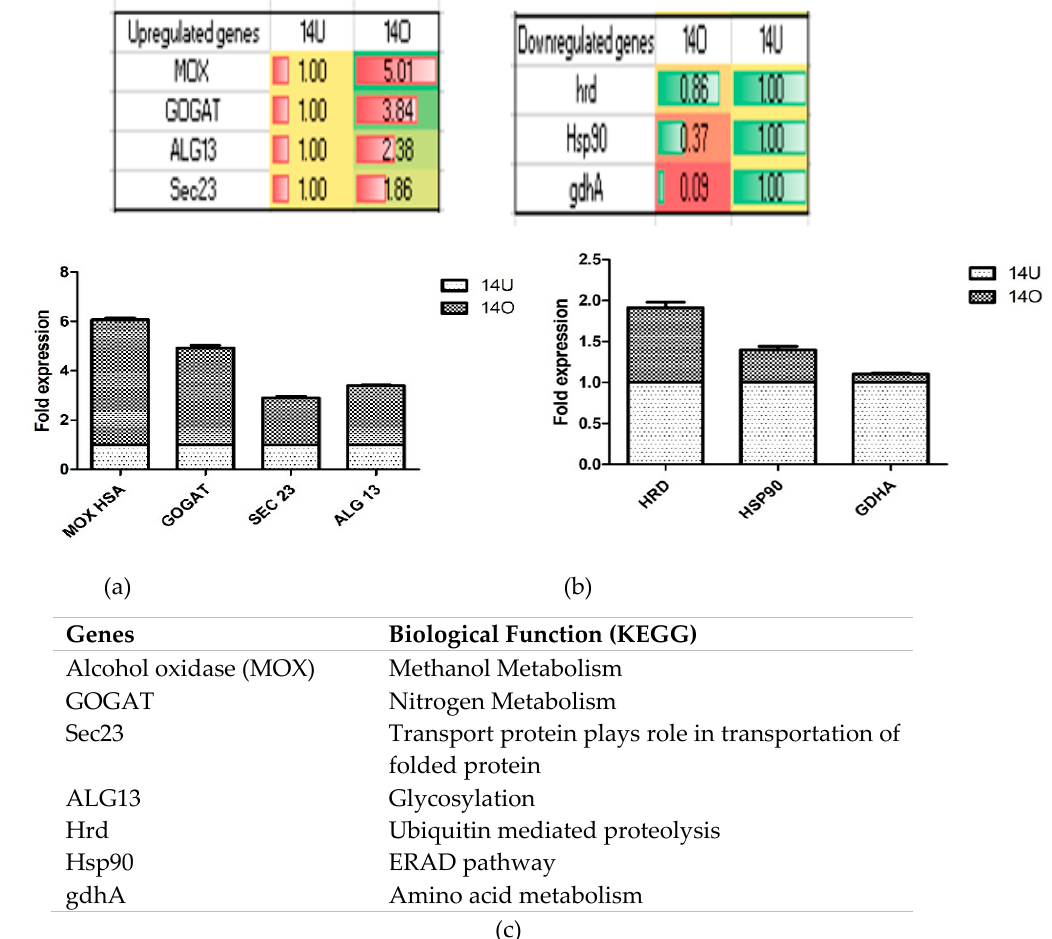
Figure 9. Qualitative polymerase chain reaction (QPCR) analysis of some ( a ) up- and ( b ) down- regulated genes under optimized vs. unoptimized media conditions. ( c ) Biological function of the genes mentioned in ( a ) and ( b ).